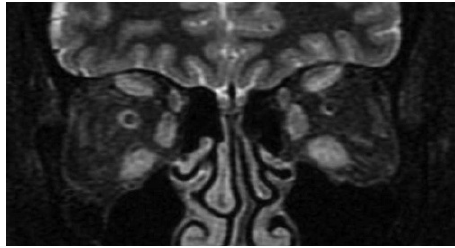
Figure 3 - Coronal STIR MR image showing a bright signal from the superior oblique muscles and inferior, medial and superior recti muscles in both orbits in a patient with active Graves’ orbitopathy.